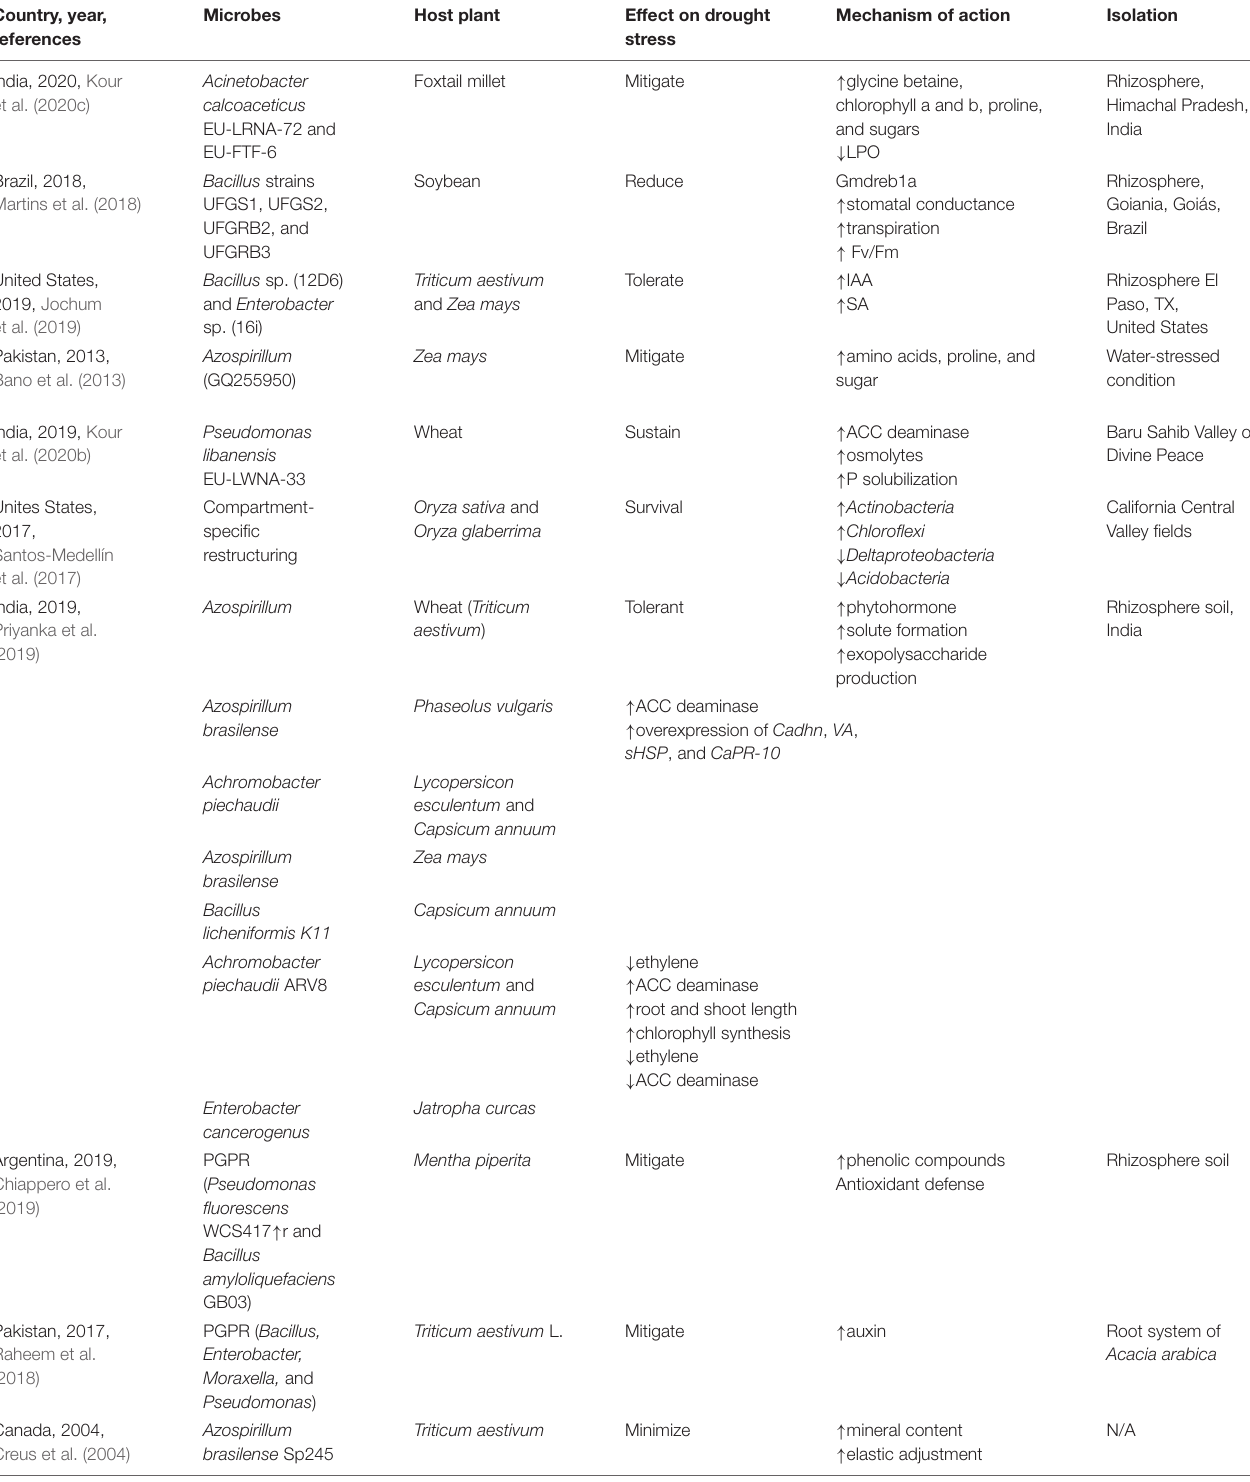
TABLE 4 | Plant-growth-promoting rhizobacteria and drought